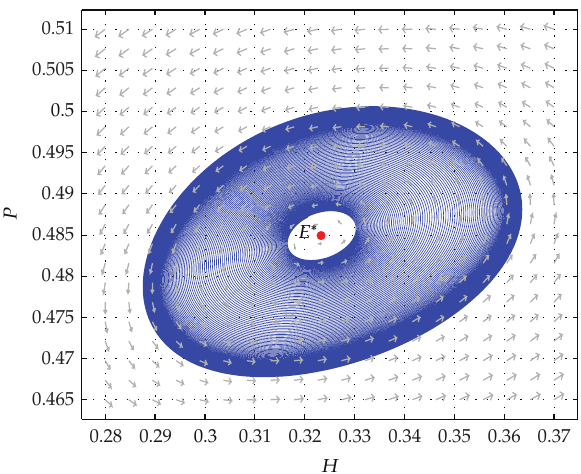
Figure 4: The phase portrait of model (7) with the weak Allee effect. The parameters are taken as 𝑎 = 0.25 , 𝛿 = 0.8 , 𝑚 = 1.3 , and 𝑟 = 0.1 . In this case, 𝐸 0 = (1,0) is saddle point; the positive equilibrium 𝐸 ∗ = (0.3232928050, 0.4849392075) is globally asymptotically stable. The dotted curves are the nullclines.